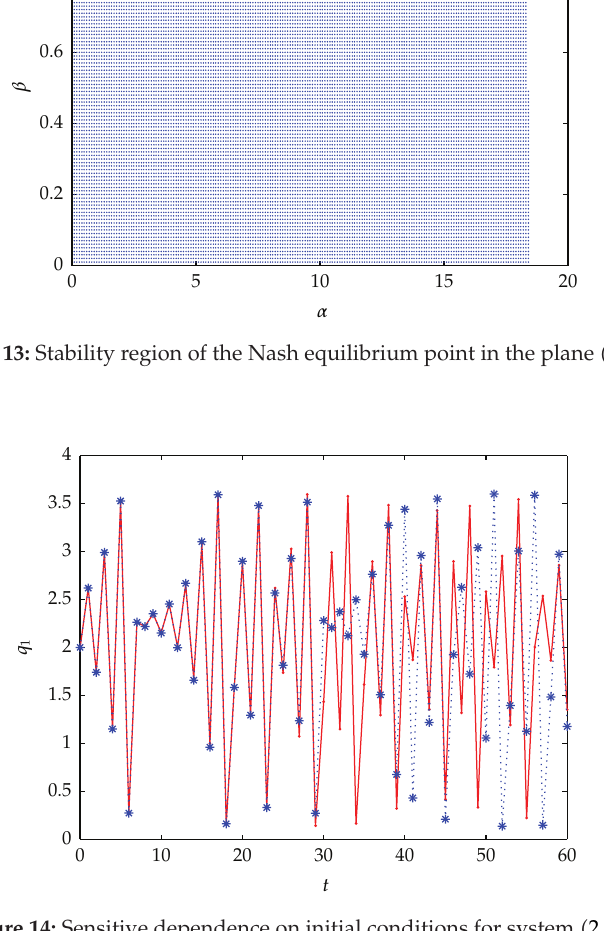
Figure 14: Sensitive dependence on initial conditions for system (cid:2) 2.9 (cid:3)